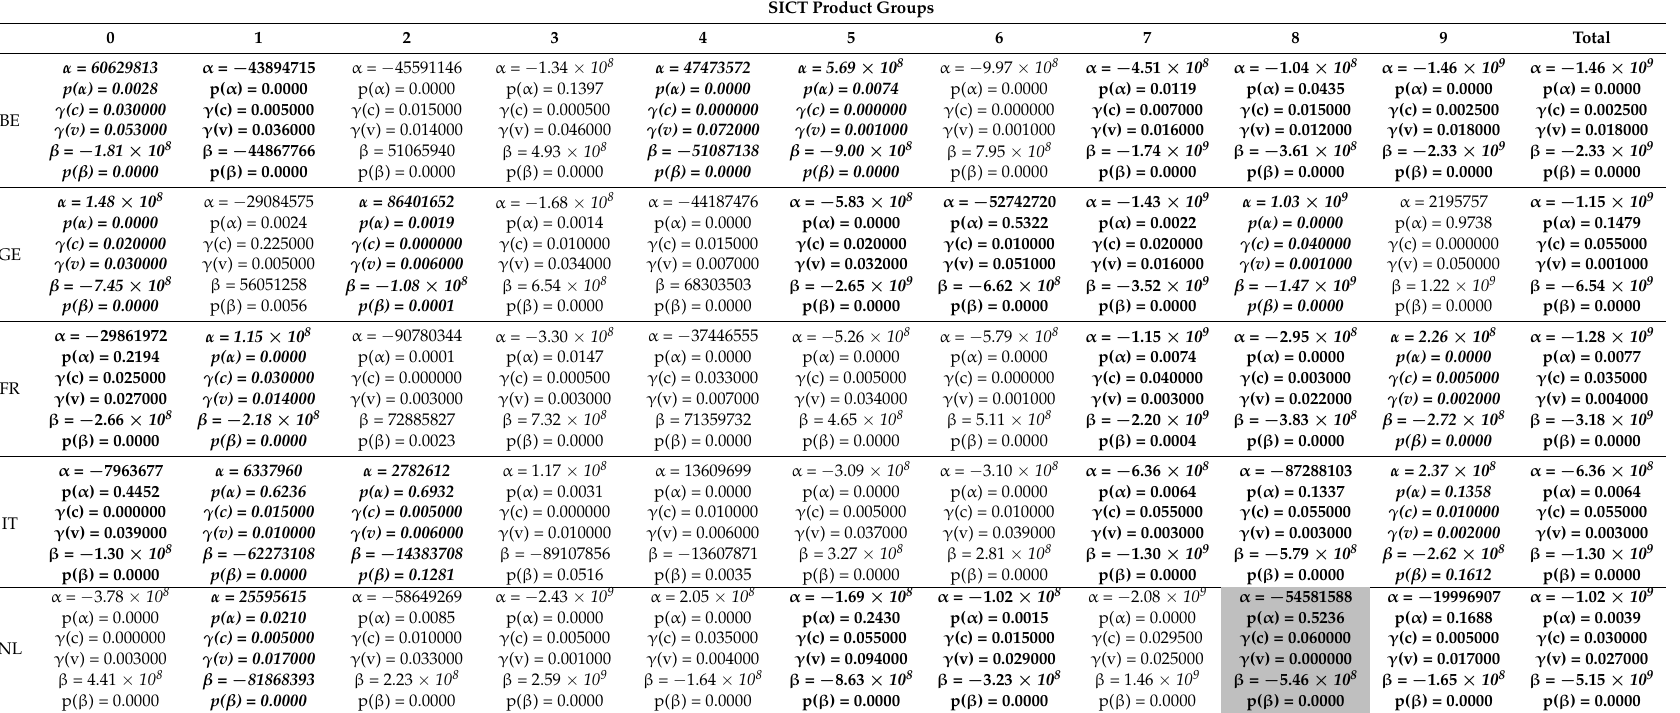
Table A4. Hysteresis with a variable play area (Euro Stoxx